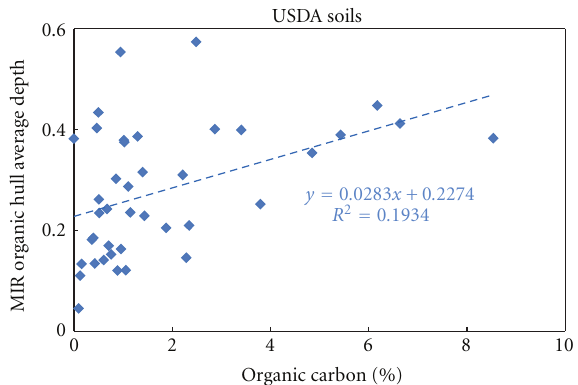
Figure 17: MIR organic hull average depth index versus the USDA supplied Organic Carbon content for organic carbon less that 10%